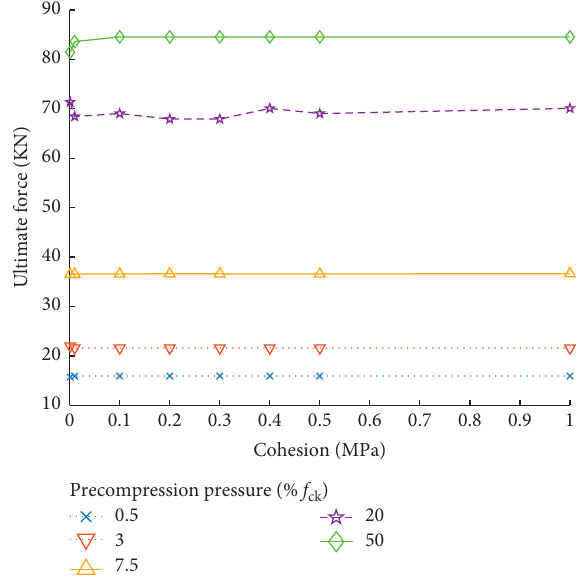
Figure 18: Ultimate force vs cohesion for varying precompression pressures.